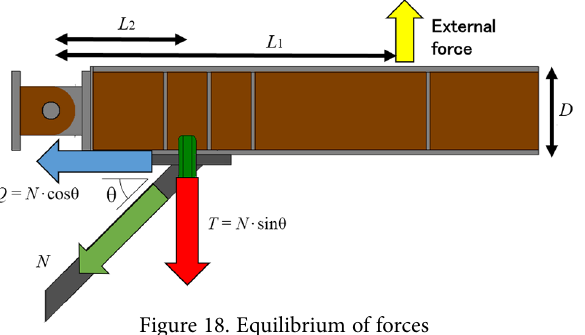
Figure 19. π gauge